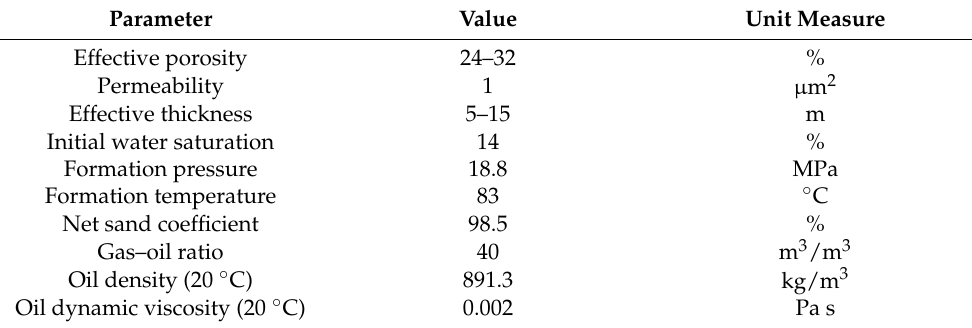
Table 9. Reservoir and fluid parameters of the Avaldsnes section of the Johan Sverdrup field.